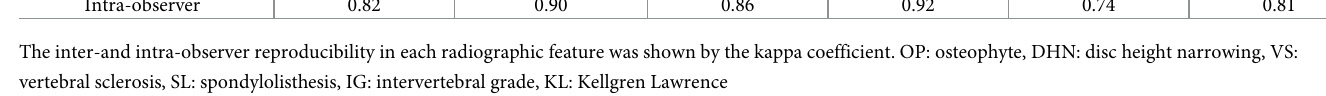
Table 2. Inter-, intra-observer reliability of novel elemental grading system. OP DHN SL